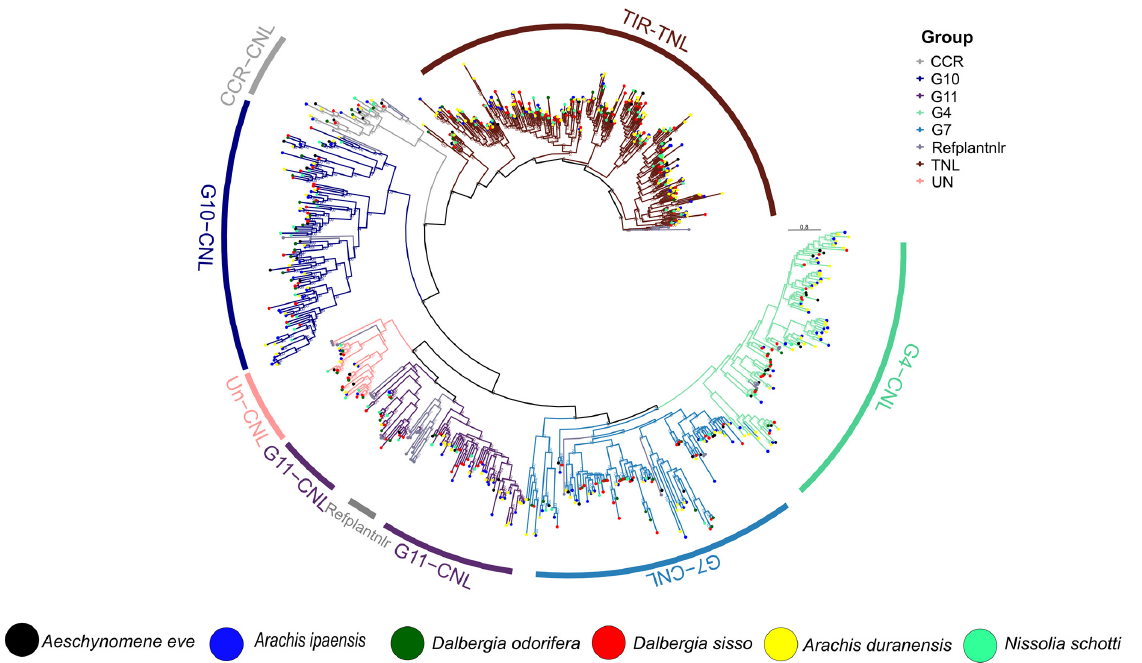
Figure 3. Phylogenetic reconstruction of NLR gene identified from Dalbergioids species.